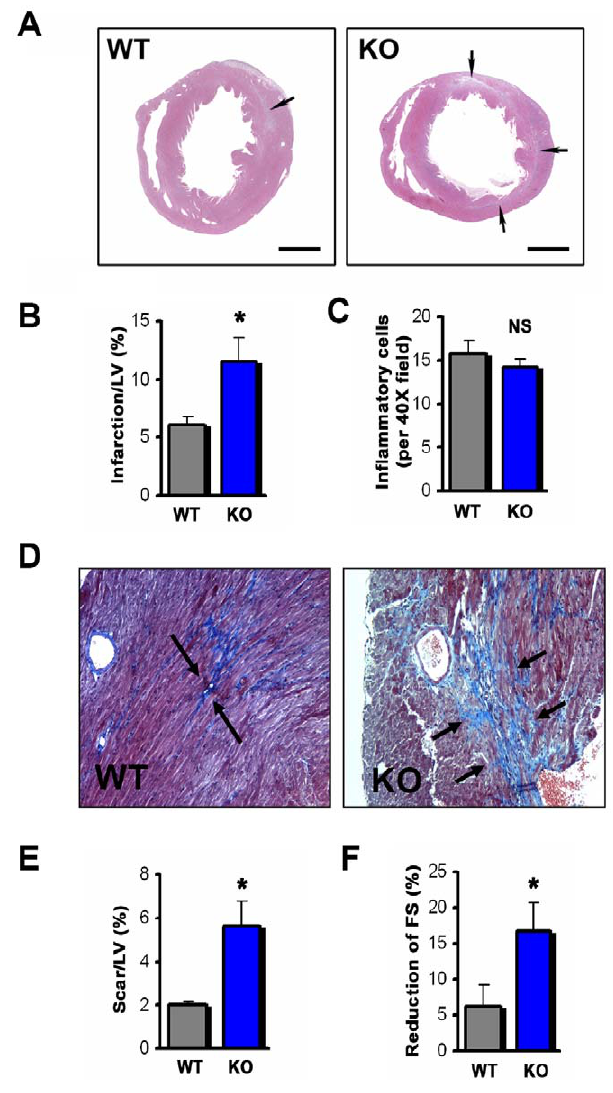
Figure 2. Loss of PI3K c results in long term myocardial ischemia/reperfusion induced heart damage. ( A ) Areas of infarction (arrows) in representative left mid-ventricular sections 1 week after M I/R injury. (H&E staining). Bars indicate 1 mm. ( B ) PI3K c 2 / 2 (KO) hearts show a markedly greater infarction size in the left ventricle (LV) at 1 week after M I/R. n=7 per group. ( C ) No significant difference between PI3K c 2 / 2 and WT mice in the numbers of infiltrating inflammatory cells 1 week after M I/R. n = 7 per group. ( D ) Representative left mid-ventricular sections stained with Trichrome and Aniline blue to visualize collagen deposits (arrows) in hearts of PI3K c 2 / 2 (KO) and wild type (WT) mice 3 weeks after M I/R. Magnifications 6 20. ( E ) Markedly increased scar tissue in PI3K c 2 / 2 3 weeks after M I/R injury. n=7 per group. ( F ) PI3K c 2 / 2 mice exhibit a significant greater loss in percentage fractional shortening (FS) relative to their respective baseline FS after 3 weeks of M I/R compared to WT controls. n=9 per group. In all bar graphs mean values + / 2 SEM are shown. *p , 0.05. NS=not significant.